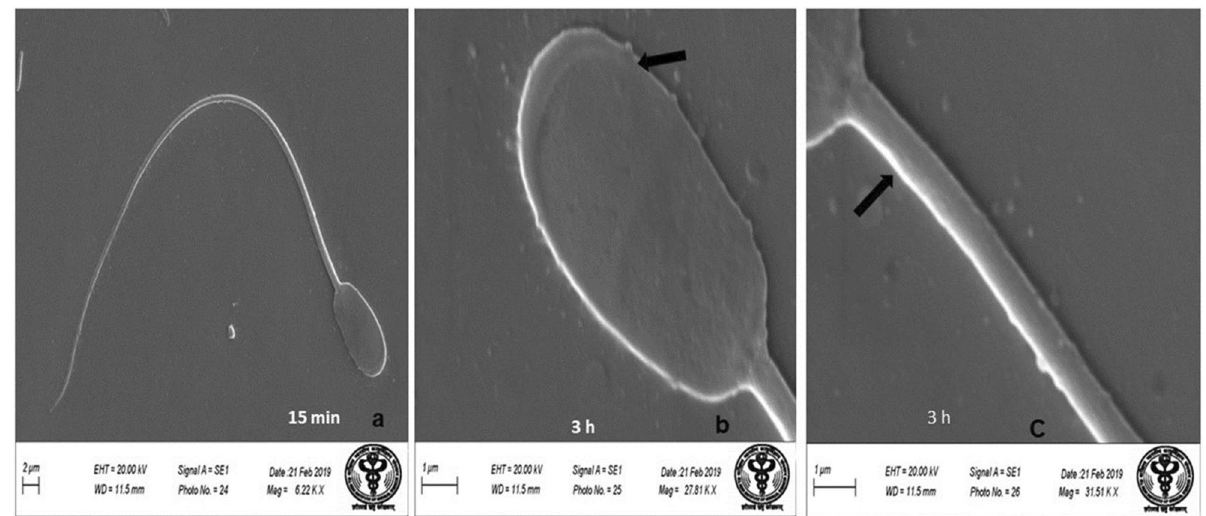
Figure 4. Buck spermatozoa of control group showing normal surface morphology. Scanning Electron Microscope images of buck spermatozoa of control group shows normal surface morphology ( a ), intact acrosome ( b ) and intact midpiece ( c ) after 15 and 3 h.